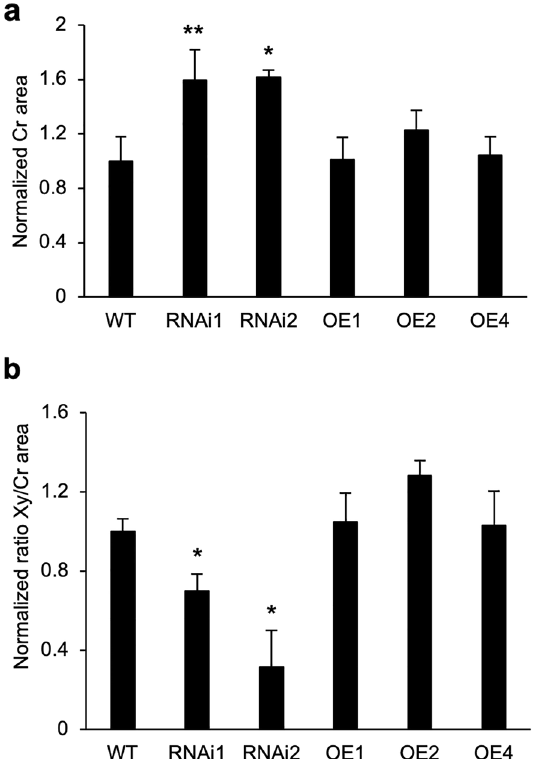
Fig. 7 Effect of CWPO‑C expression on stem and xylem formation in transgenic poplar. a Cross‑sectional (Cr) area of whole basal stem. b Ratio of xylem/whole cross‑sectional (Xy/Cr) area. Data are presented relative to the WT, which was set to 1. Mean standard deviation ± of four biological replicates. *: significant difference ( p ˂ 0.05), **: